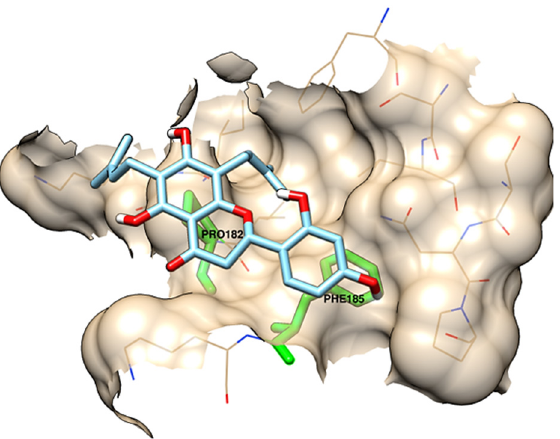
Figure 4. Allosteric site described by Kwon and colleagues [24]. The docked flavonoid Kushenol E, as well as Pro182, and Phe185 are shown in detail.